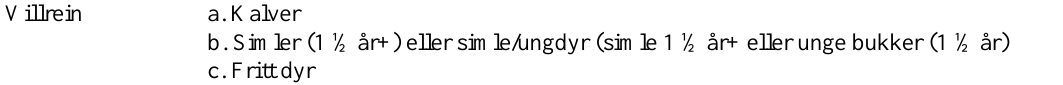
Tabell 2. Jaktkvotene for villrein og (hjort og elg) er alders- og kjønnsdefinert (Gjems et al ., 2004).